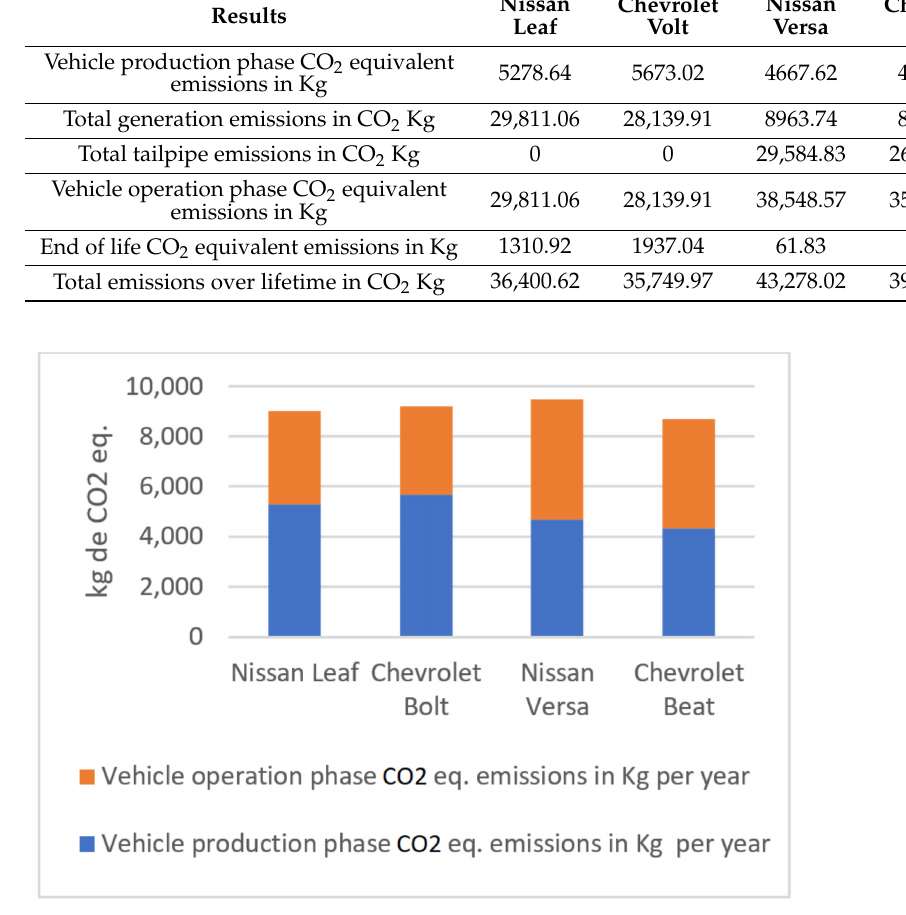
Figure 14. Annual CO 2 equivalent emissions of different